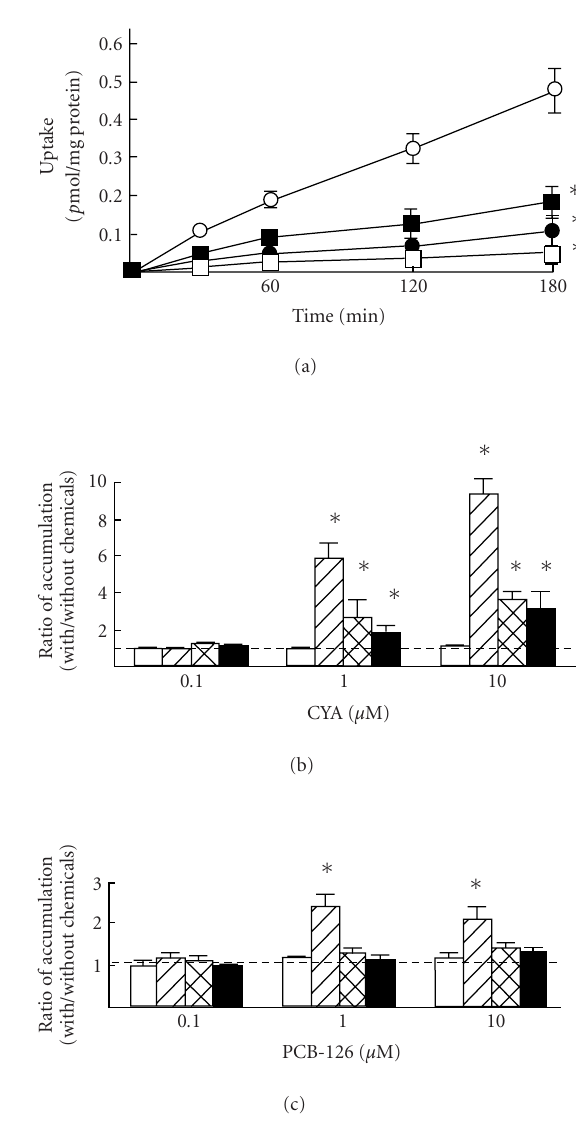
Figure 2. (a) Uptake of colchicine in KB3-1 expressing with wild-type human P-glycoprotein (KB3-His 61 , filled circles), mu- tant P-glycoprotein in which His 61 was replaced with pheny- lalanine (KB3-Phe 61 , open squares) and serine (KB3-Ser 61 , filled squares), and transfected with transfection vector (KB3- Vec, open circles). (b) The ratios between the accumula- tions of colchicine with and without cyclosporine A (CYA) and (c) PCB-126 (with/without CYA or PCB-126) in KB3- Vec (open columns), KB3-His 61 (cross-hatched columns), KB3- Phe 61 (hatched columns), and KB3-Ser 61 (filled columns). ∗ , P < . 05 compared to KB3-Vec. Means and SD of 4 experiments.